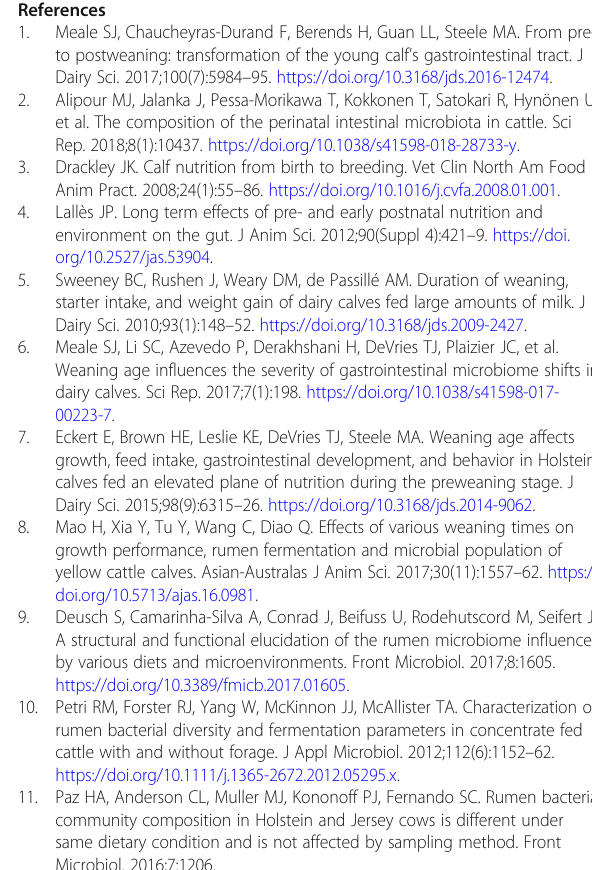
Additional file 1: Figure S1 . Shannon index of RS bacterial communities in R and BS samples of different age group calves. Figure S2 . Overlap of RS-OTUs covering V1-V2 region of bacterial 16S rRNA. Fig- ure S3 . Average relative abundances of RS bacterial phylum- and genus- level taxa in rumen and buccal swab samples of different age group calves. Figure S4 . a Principal coordinates analysis plot of bacterial com-